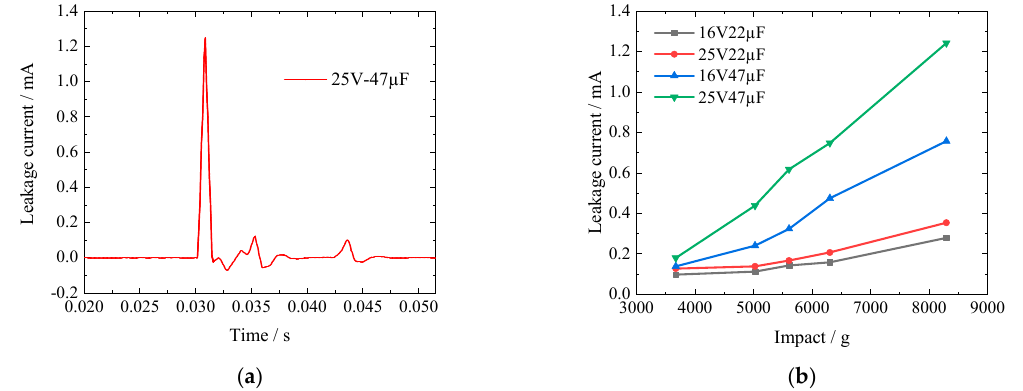
Figure 4. Relationship between the leakage current and impact in multilayer ceramic capacitors: ( a ) leakage current of an MLCC (25V47 µ F) under 8297 g impulse; ( b ) leakage current variation of multilayer ceramic capacitors with different impacts.